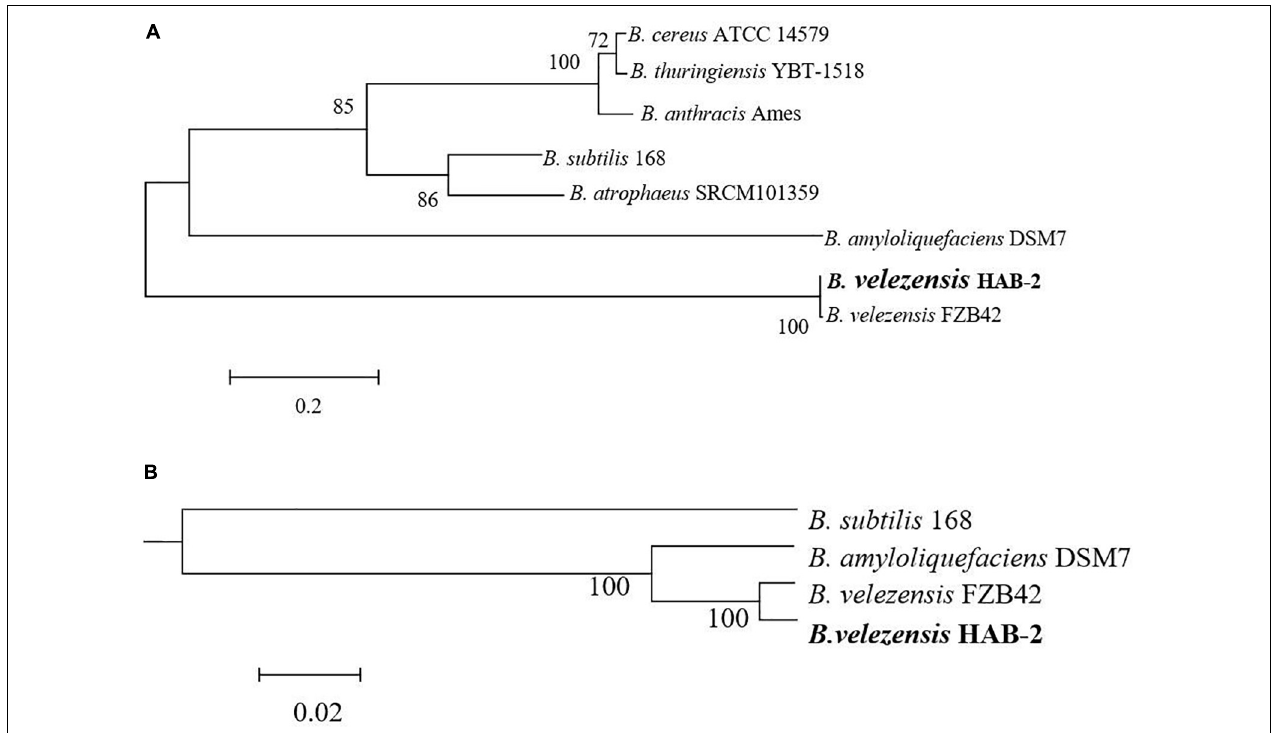
FIGURE 3 | Phylogenetic analysis for B. velezensis HAB-2 and reference Bacillus strains. (A) Phylogenetic tree drawn from the 16S rRNA of Bacillus spp. (B) Phylogenetic tree drawn from the core genomes of HAB-2, FZB42, DSM7 and 168. Bootstrap values are indicated in% of